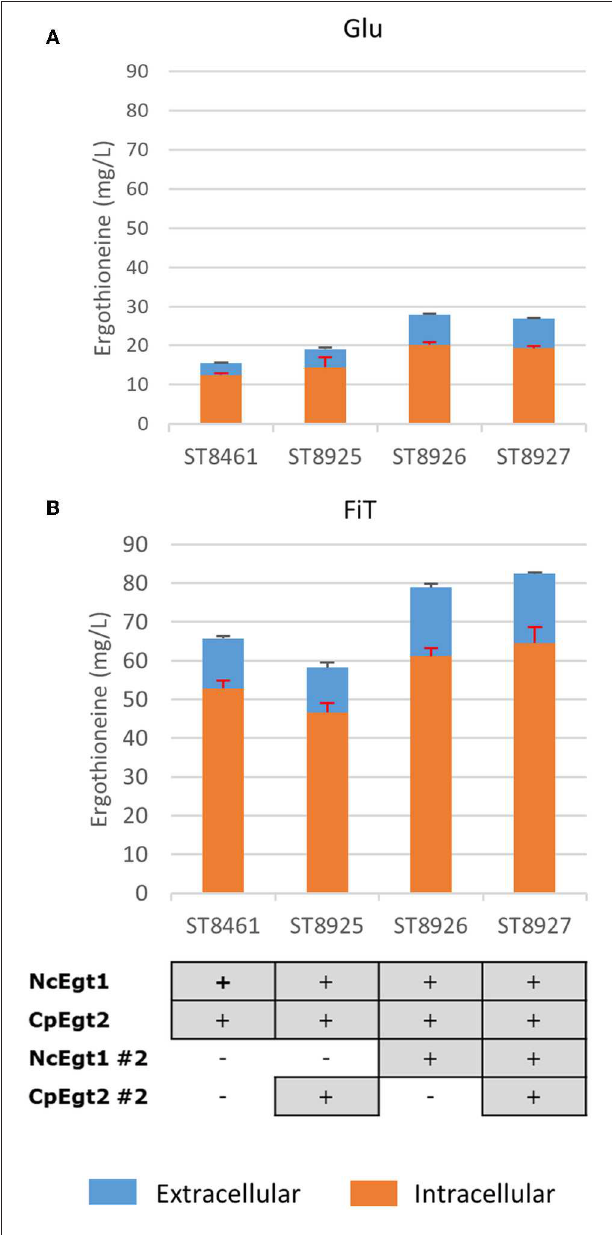
FIGURE 7 | The effect of the integration of a second copy of Egt enzymes on the production of ergothioneine in the high producing strain in different media. Genomic alterations are shown as well. (A) Glu: SC + 40 g/l glucose (B) FiT: SC + 60 g/l EnPump substrate, 0.6% reagent